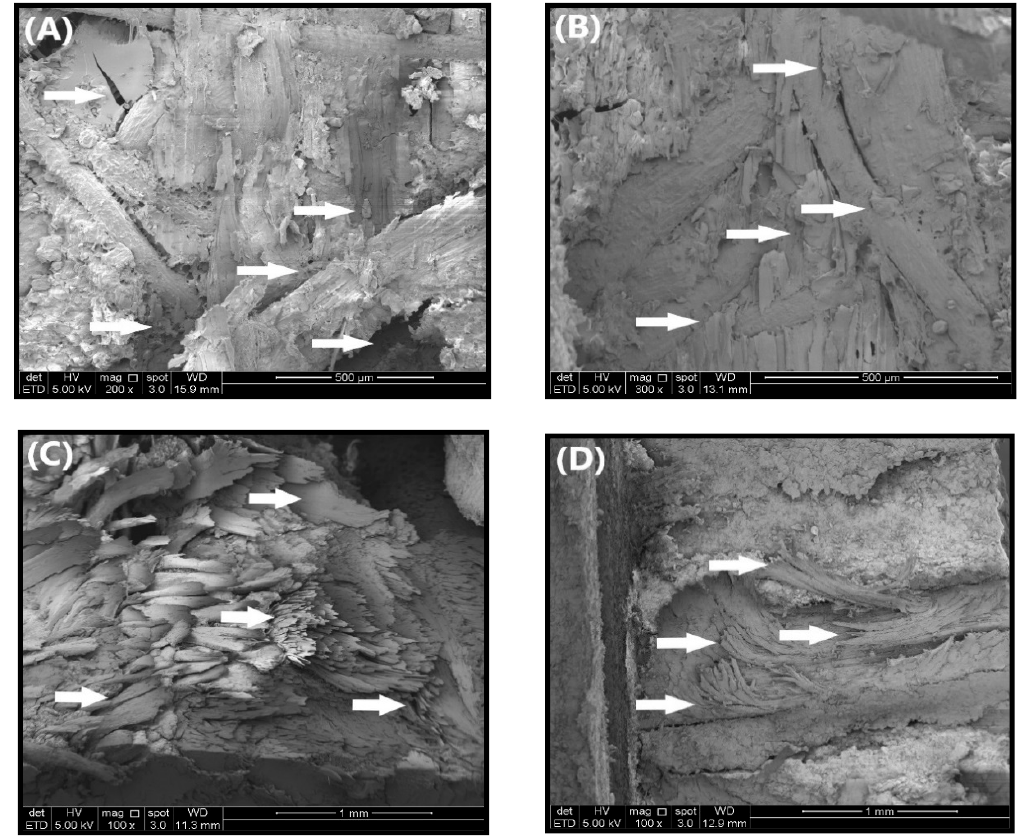
Figure 9. SEM micrograph of shear fracture morphology ( A ) PWH with neat PF resin; ( B ) PWH with PF resin-filled 3% OPA nanoparticles loading; ( C ) PWV with neat resin and ( D ) PWV with PF resin-filled 4% OPA nanoparticle